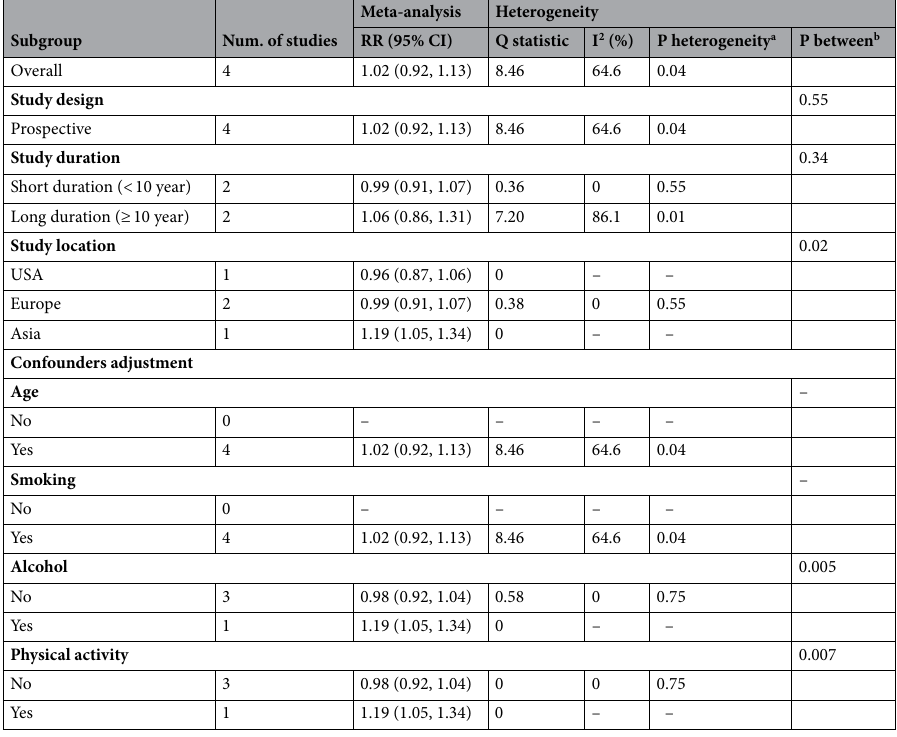
Table 2. Meta-analysis of body mass index and risk of prostate cancer in patients with T2D (all analyses were conducted using random-effects models). RR relative risk, CI confidence interval. a p-value for heterogeneity within groups. b p-value for heterogeneity between